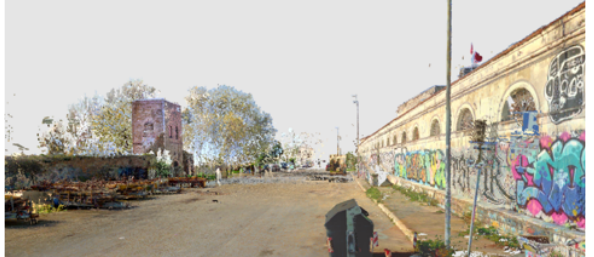
Figure 2: Dense Cloud of the study area, the bank of the Tiber in front of the former slaughterhouse, imported into the Autodesk ReCap management program.